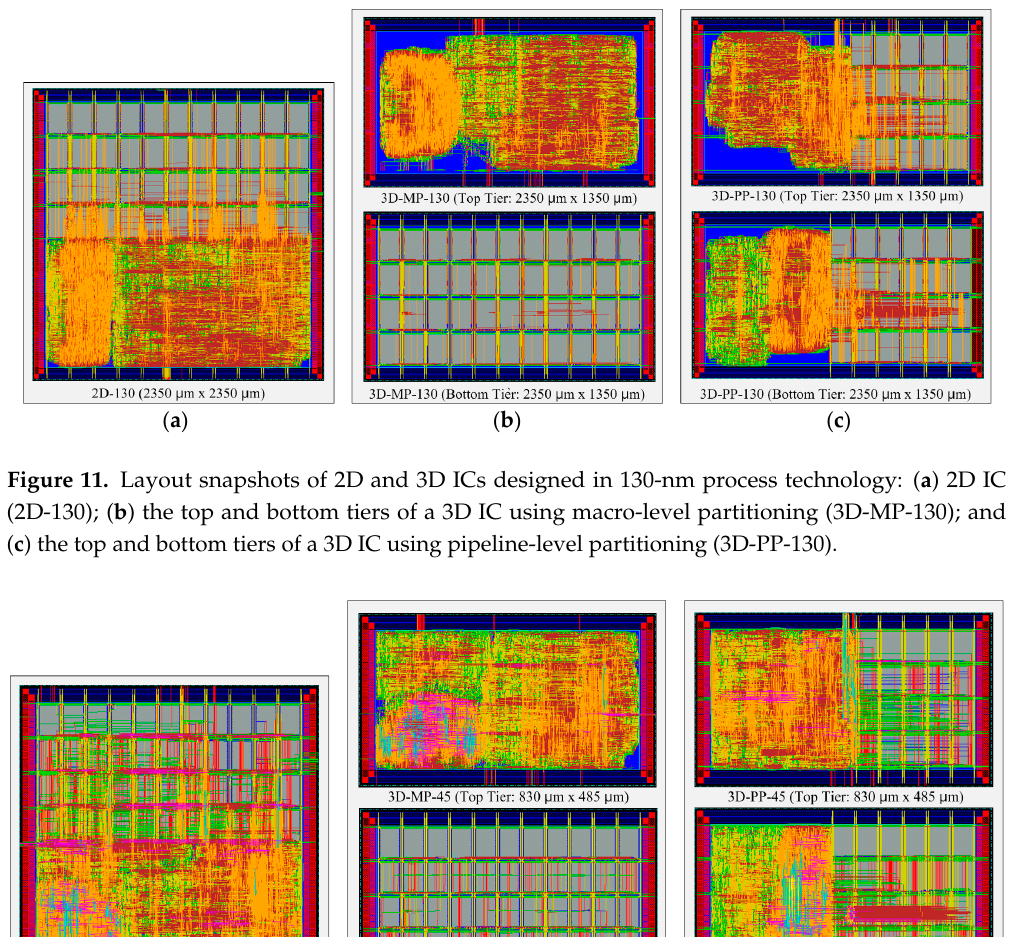
Figure 10. Comparisons between the normalized designs of 2D and 3D ICs: ( a ) 2D and 3D ICs designed in 130-nm process technology; and ( b ) 2D and 3D ICs designed in 45-nm process technology. Sensors 2017 , 17 , 426